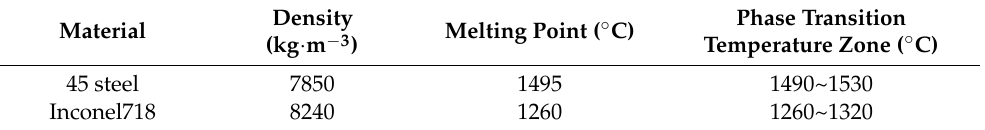
Table 1. Basic physical